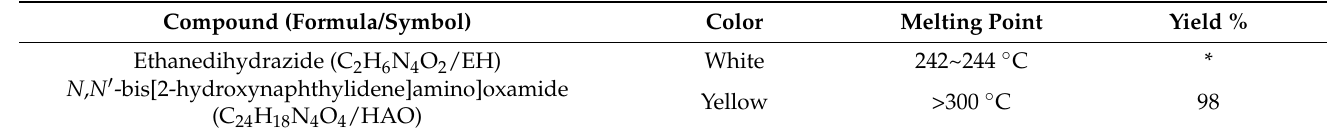
Table 1. Physical data of the inhibitor (HAO) and its corresponding hydrazide (EH). Compound (Formula/Symbol) Color Melting Point Yield % Ethanedihydrazide (C 2 H 6 N 4 O 2 /EH) White 242~244 ◦ C * N , N (cid:48)